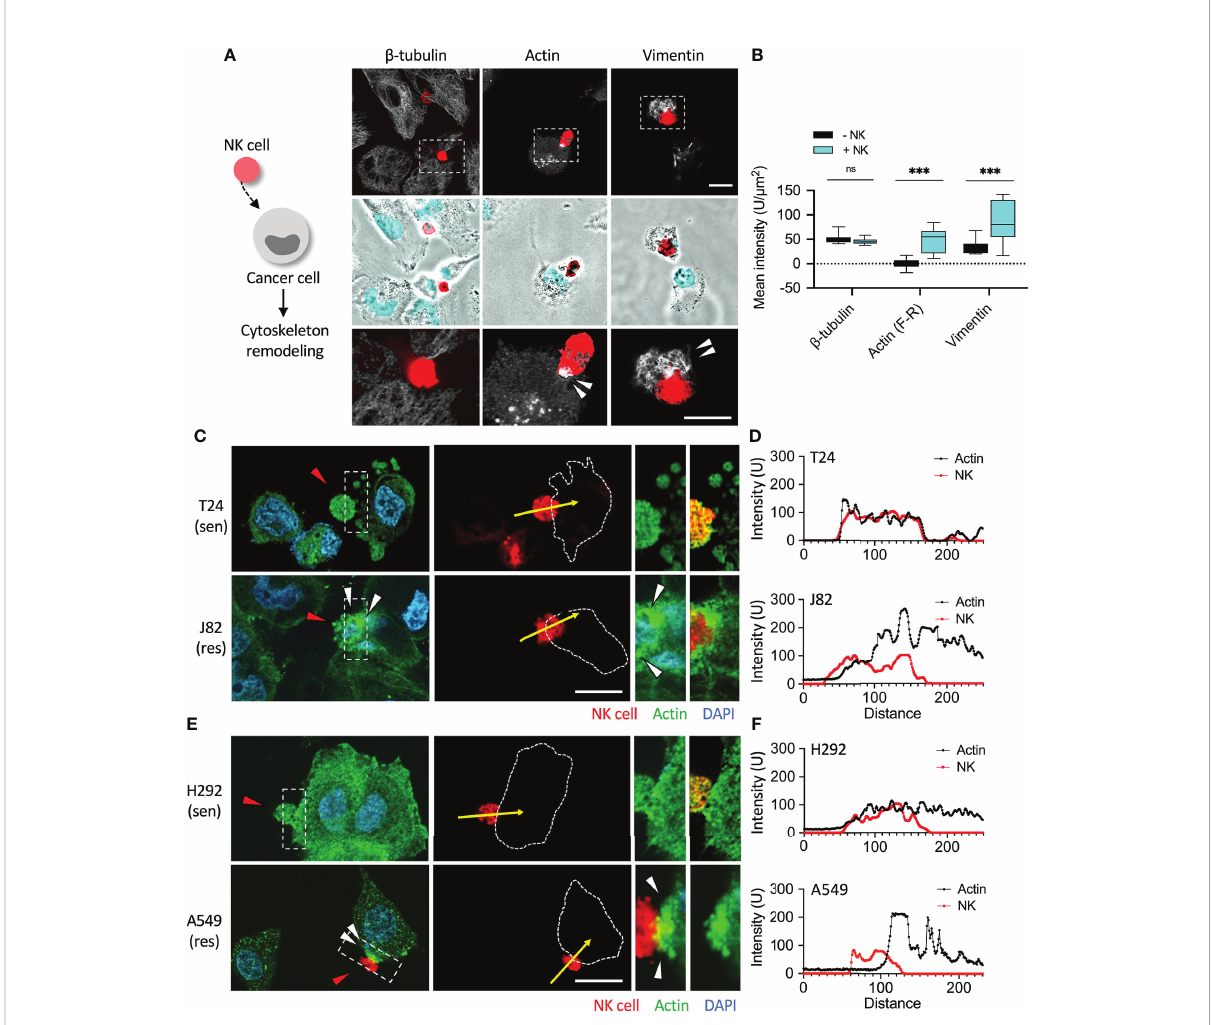
FIGURE 2 Induction of cytoskeleton remodeling by NK cells. (A, B) Comparison of the expression of b -tubulin, vimentin and actin fi laments in NK cell- mediated cell lysis. BFTC909 cells were incubated with NK cells for 6 h and the expression b -tubulin, vimentin, and actin fi laments was detected by immuno fl uorescence assays. (C) T24 or J82 cells were co-cultured with NK cells for 6 h and stained with a b -actin antibody. The stained cells were observed using a fl uorescence microscope. (E) H292 and A549 cells were co-cultured with NK cells for 6 h and stained with a b - actin antibody. The stained cells were observed using a fl uorescence microscope. (D, F) The intensity of prominent fi brous actin near the immunologic synapse was measured and quanti fi ed by ImageJ. ns, not signi fi cant; ***P < 0.001. Data are presented as means ± s.d. (two-way ANOVA with Sidak's multiple comparisons test). Red arrowhead, NK cell; white arrowhead, actin aggregation. Scale bars, 20 m m. Experiments were repeated at three times (n =